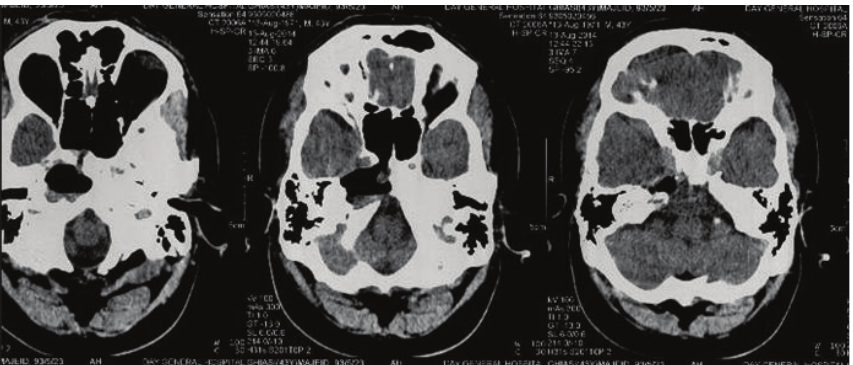
Figure 4: Axial CT scan shows acceptable aeration of right sphenoid sinus and previous location of the